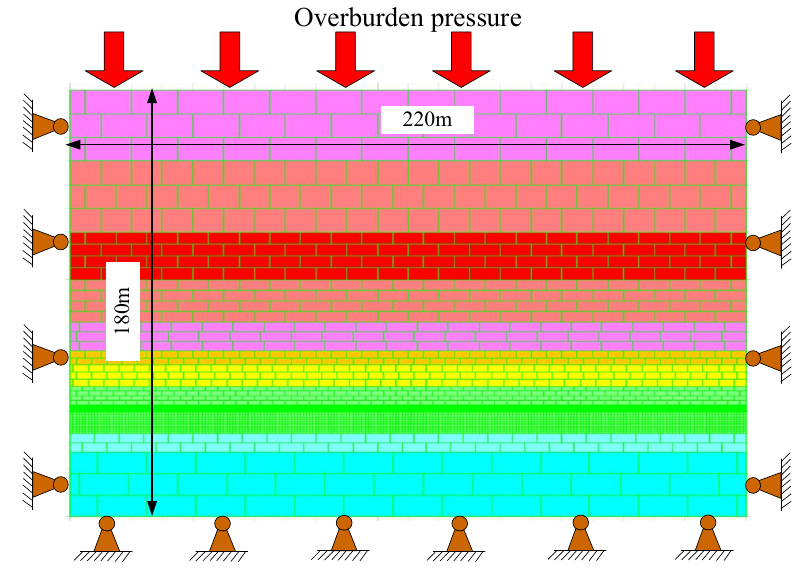
Figure 4. Diagram of UDEC model.